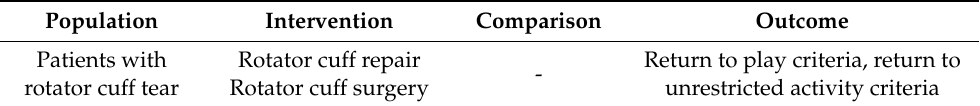
Table 1. PICO model.